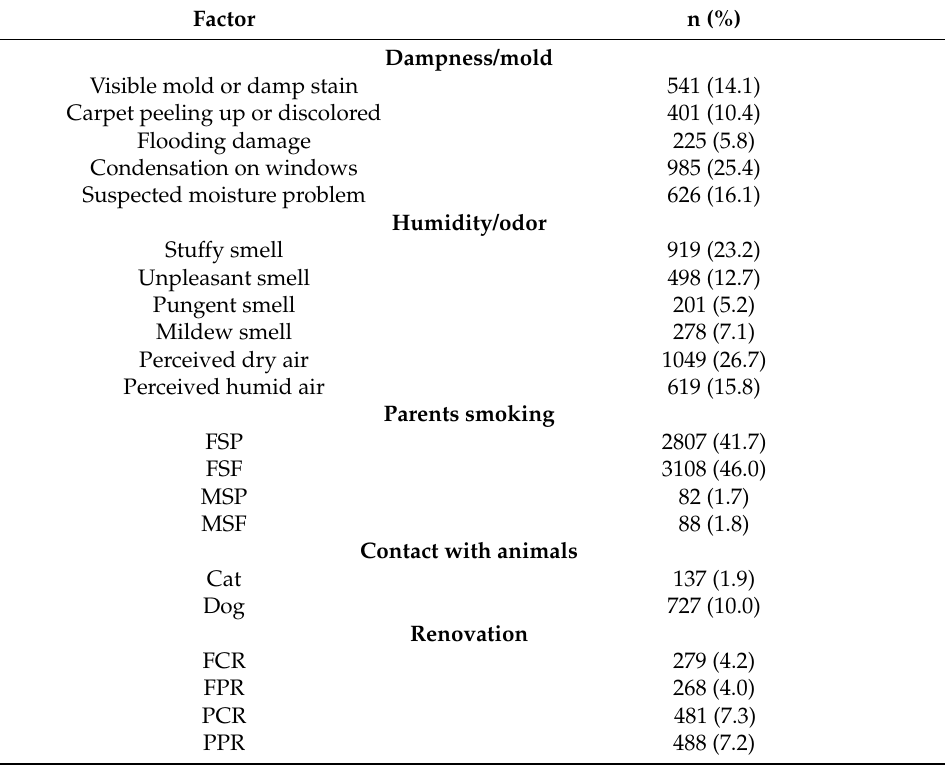
Table 2. Distribution of perinatal environmental